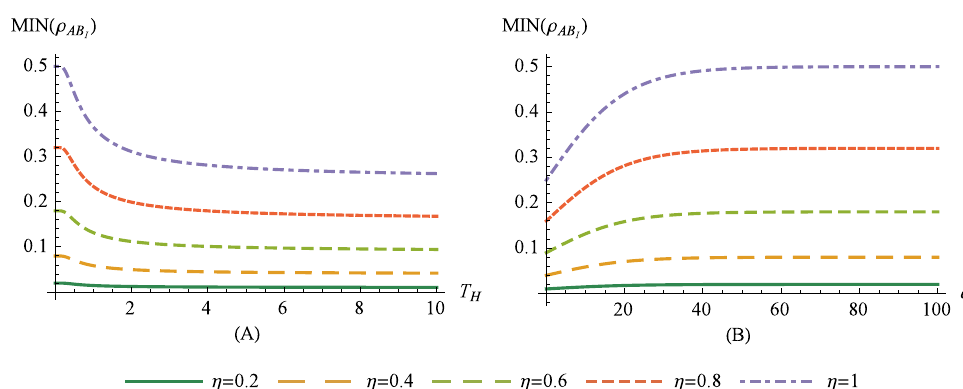
Figure 1. The measurement-induced nonlocality (MIN) as a function of ( A ) the Hawking temperature ( T H ) and ( B ) the fermionic frequency ( ω ) for the physically accessible correlations in the case of the fermionic modes ( ρ AB ). The results are presented for the selected values of the entanglement param- I eter ( η ), assuming ( A ) the fixed fermionic frequency ( ω = 1) or ( B ) the fixed Hawking temperature ( T H =